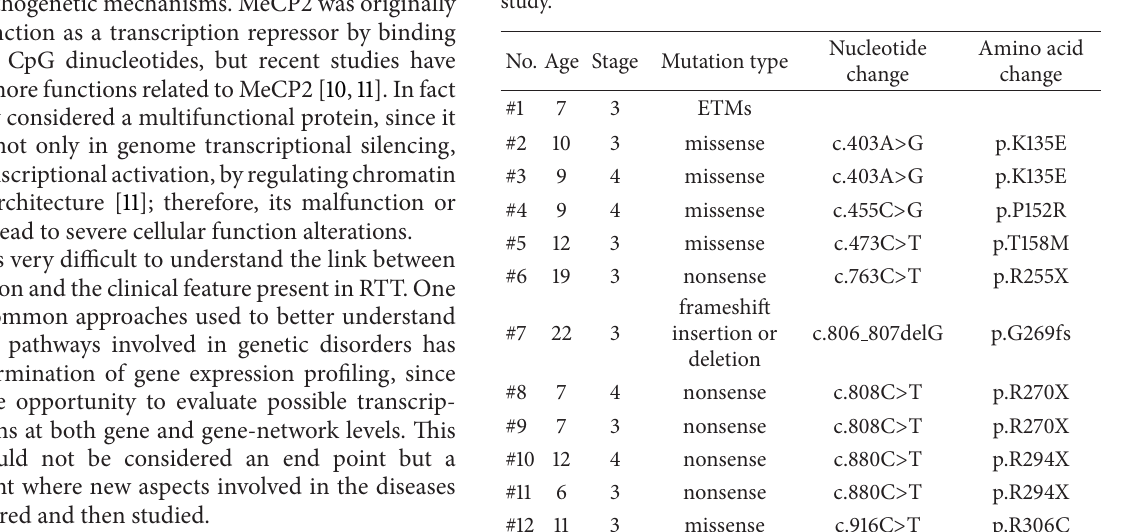
Table 1: Demographic and genetic data for RTT patients enrolled in